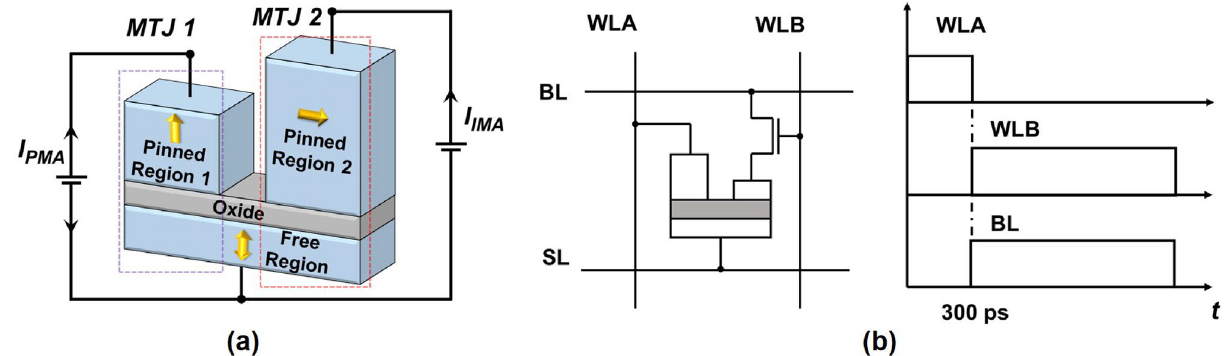
Figure 1. ( a ) Structure of the proposed device. Free region and pinned region 1 have PMA, whereas the pinned region 2 has IMA. ( b ) Proposed 1T1LDMTJ MRAM cell and its WRITE